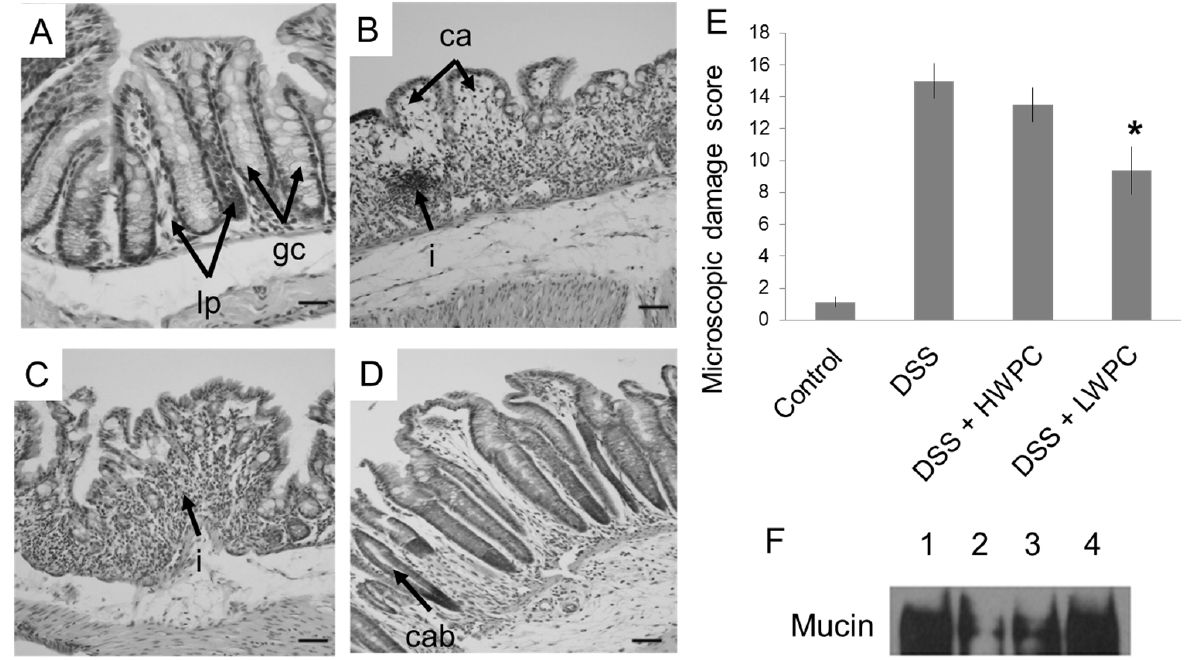
Table 1. The final scores allocated are the average values of 25 slide spots of each different treatment group. * Statistically significant difference from the DSS group ( p < 0.05). ( F ) Expression analysis of myeloperoxidase (MPO) and mucin in colon by western blot. Lane 1: normal mice without DSS treatment; lane 2: DSS-treated mice; lane 3: mice